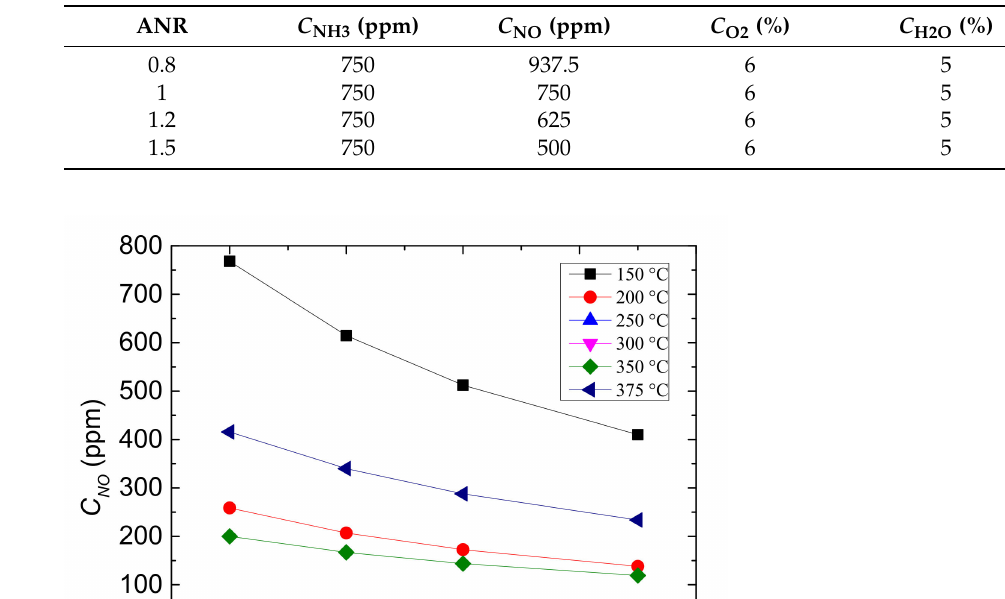
Table 2. ANR and the corresponding inlet concentrations of NH 3 , NO, O 2 and H 2 O.